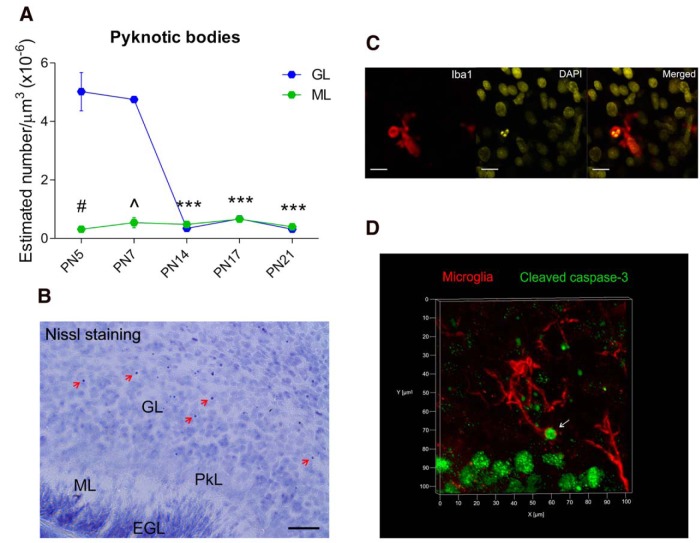
Identification of pyknotic bodies by Nissl staining in the postnatal developing cerebellum. A, The density of pyknotic bodies (red arrows) decreased only in the GL after the first postnatal week at P14, P17 and P21 (***p < 0.000), but not at P7 (p = 0.302), compared with P5. No changes in the density of pyknotic bodies were detected in the ML across the developmental time points analyzed when compared with P7 (P5, p = 0.199; P14, p = 0.688; P17, p = 0.487; P21, p = 0.375). The GL exhibited more pyknotic bodies than the ML only during the first postnatal week at P5 (#p < 0.000) and P7 (^p < 0.000). Scale bar, 25 µm. Data are expressed as mean ± SEM (*n = 6, 3 males + 3 females; ^n = 4, 2 males + 2 females: *P5, ^P7, *P14, *P17, and *P21). B, P7 cerebellar sagittal section stained with cresyl violet showing pyknotic bodies pointed out by red arrows. Pk, Purkinje layer; EGL, external granular layer. C, Confocal colocalization of a pyknotic body (fragmented nucleus in yellow) and a phagocytic cup (red) in the cerebellar cortex at P17. Scale bars, 15 µm. D, 3D confocal image depicting a colocalization of a microglial phagocytic cup (red) and a cleaved caspase-3-positive cell (green) at the tip of a microglia process (white arrow).